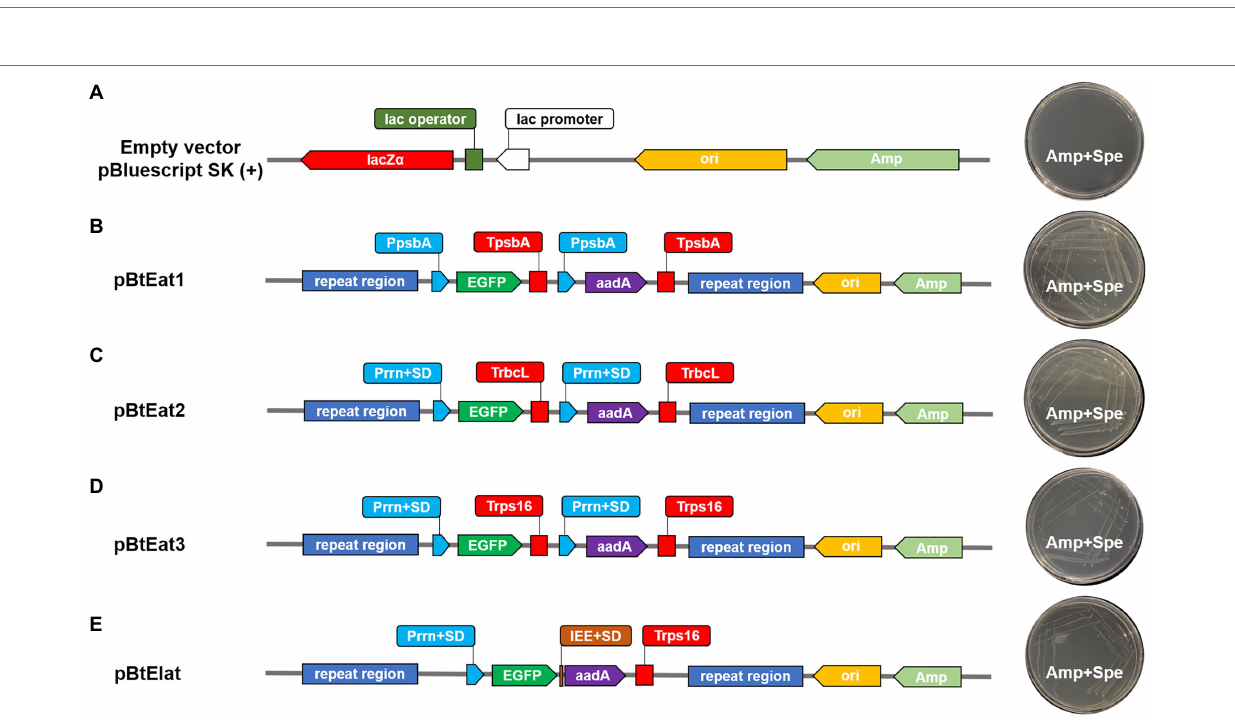
FIGURE 5 | The expression of aadA gene in Escherichia coli . (A) : Escherichia coli containing empty vector, (B–E) : Escherichia coli containing recombinant